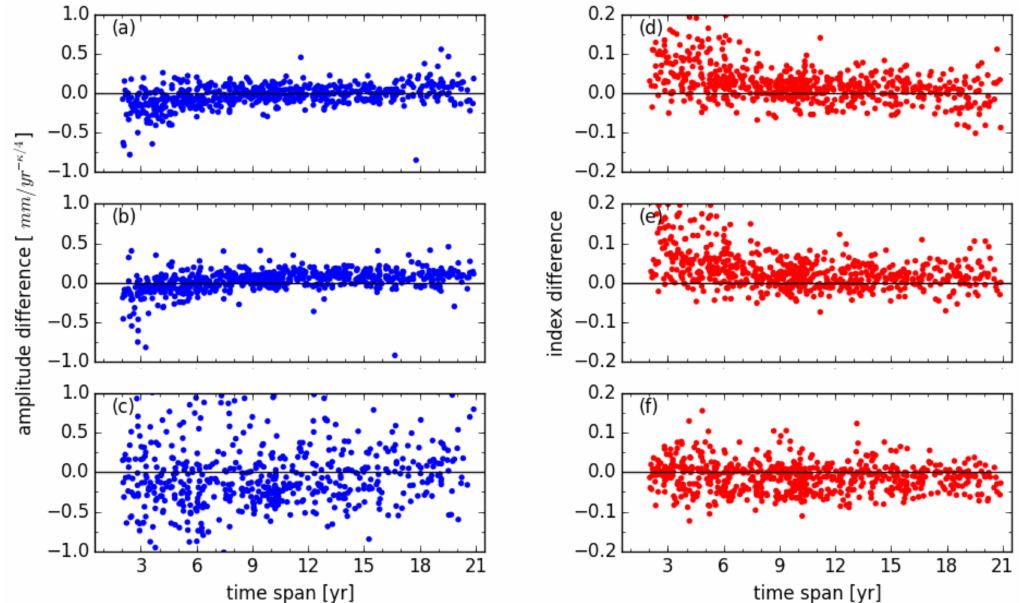
Figure 9. Noise difference between the solution igs_unit_none solution igs_cova_trs for amplitudes ( left panel ) and spectral indexes ( right panel ) of the power law noise, with ( a , d ) for the east, ( b , e ) for the north, and ( c , f ) for the vertical